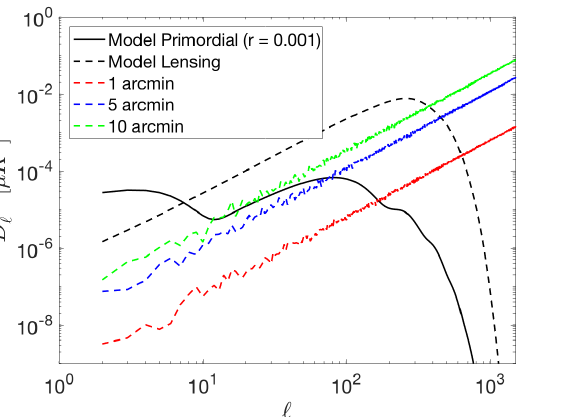
Figure 4. BB signals produced by random pointing errors of 10 (green), 5 (blue) and 1 (red) arc-minute.